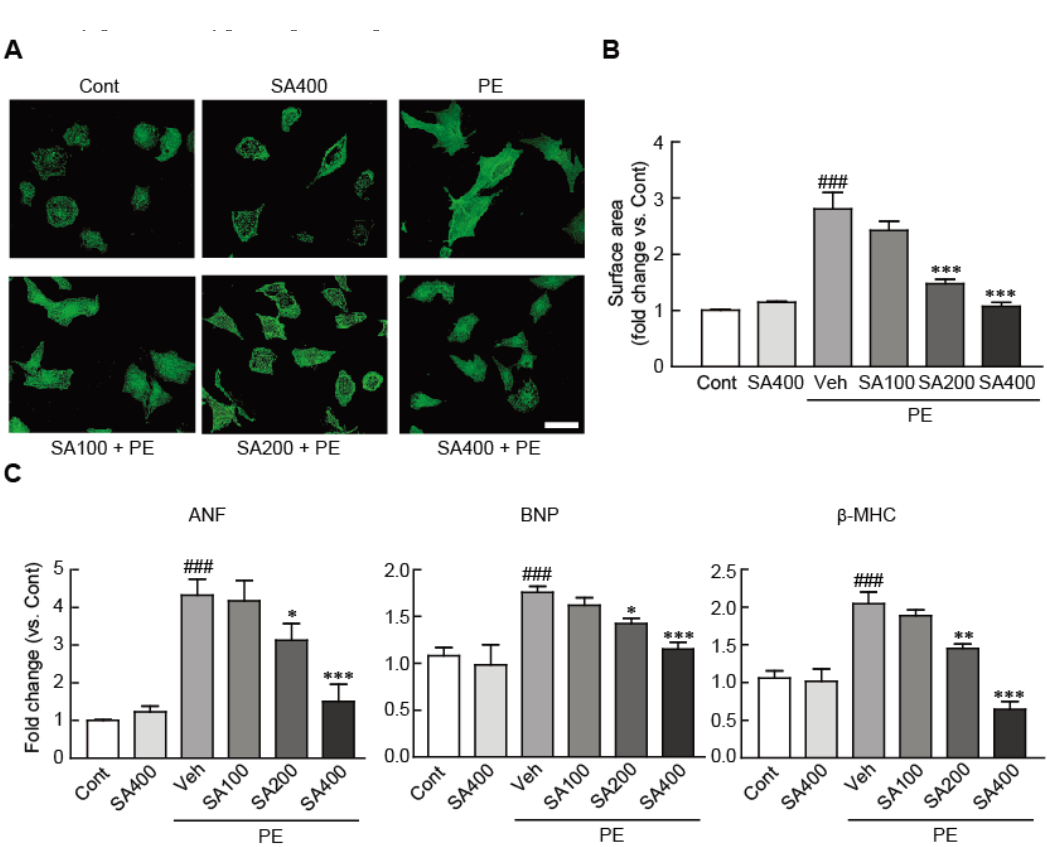
Figure 2. SA attenuates hypertrophic responses in PE-treated cardiomyocytes. ( A ) Representative photograph of cardiomyocytes pretreated with 100, 200, and 400 µ M SA for 24 h, followed by treatment with 100 µ M PE. Sarcomeric organization was visualized by α -actinin staining. Scale bar, 50 µ M. ( B ) Cell-surface areas were measured by using NIH ImageJ software ( n = 100 cells per group). ( C ) qRT-PCR analysis of ANF, BNP, and β -MHC mRNA expression. The analyses were performed in triplicate, using three independent samples. Data are expressed as the mean ± standard error of the mean (SEM). Significance was assessed by one-way analysis of variance (ANOVA) with a Bonferroni post hoc test. ### P < 0.001 vs. the control group; * P < 0.05, ** P < 0.01, and *** P < 0.001 vs. the PE-only treated group. Veh, vehicle-treated; SA100, SA200, and SA400, 100, 200, and 400 µ M SA-treated groups, respectively; PE, phenylephrine; Cont, control; SA, sinapic